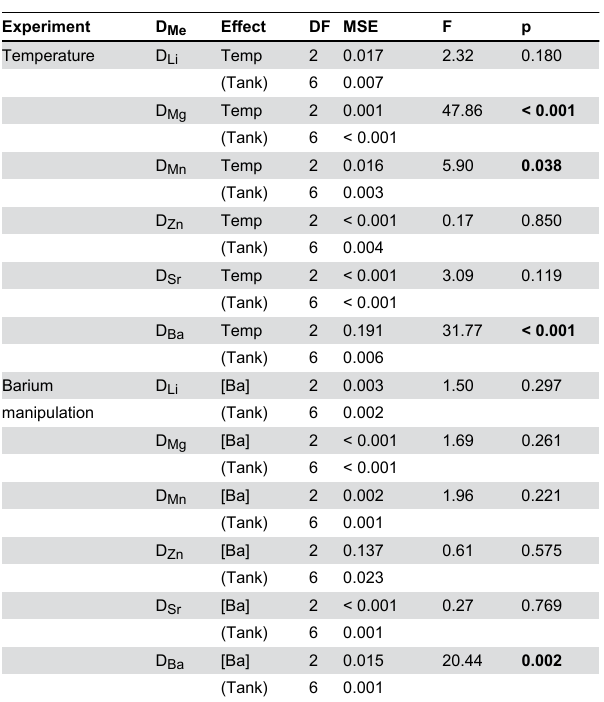
Table 3. Results of nested analysis of variance to evaluate the effect of temperature (Temp; 15°C, 18°C, and 24°C) and barium ([Ba]; 1x, 3x, and 6x average ambient values) treatments on mean partition coefficients (D Me